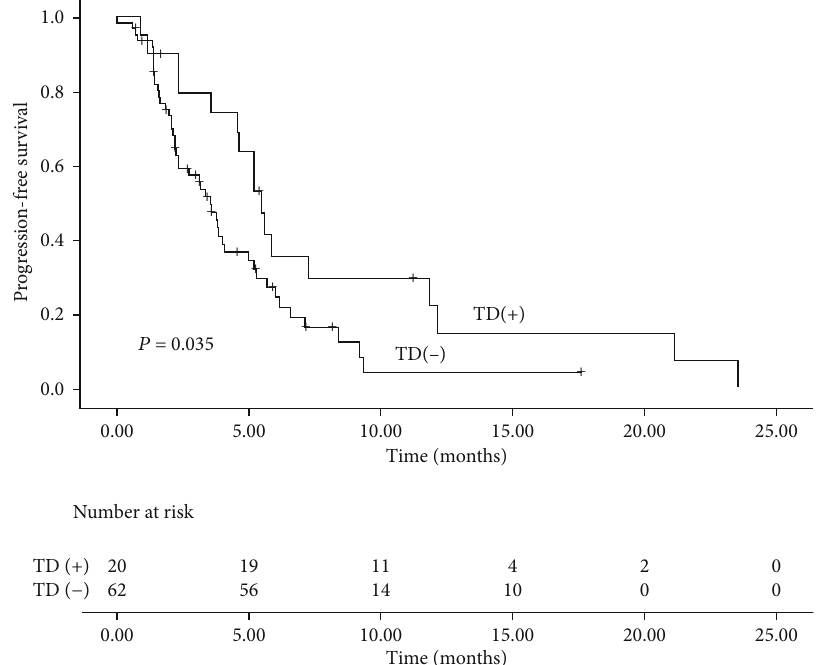
Figure 1: Progression-free survival in ESCC patients with and without TD.